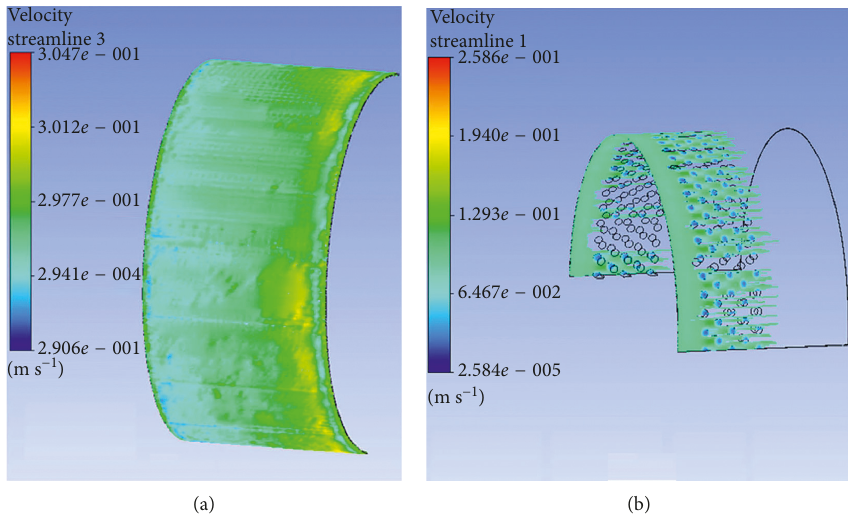
Figure 10: Piston surface streamline: (a) L-Standard piston and (b) dimpled piston.